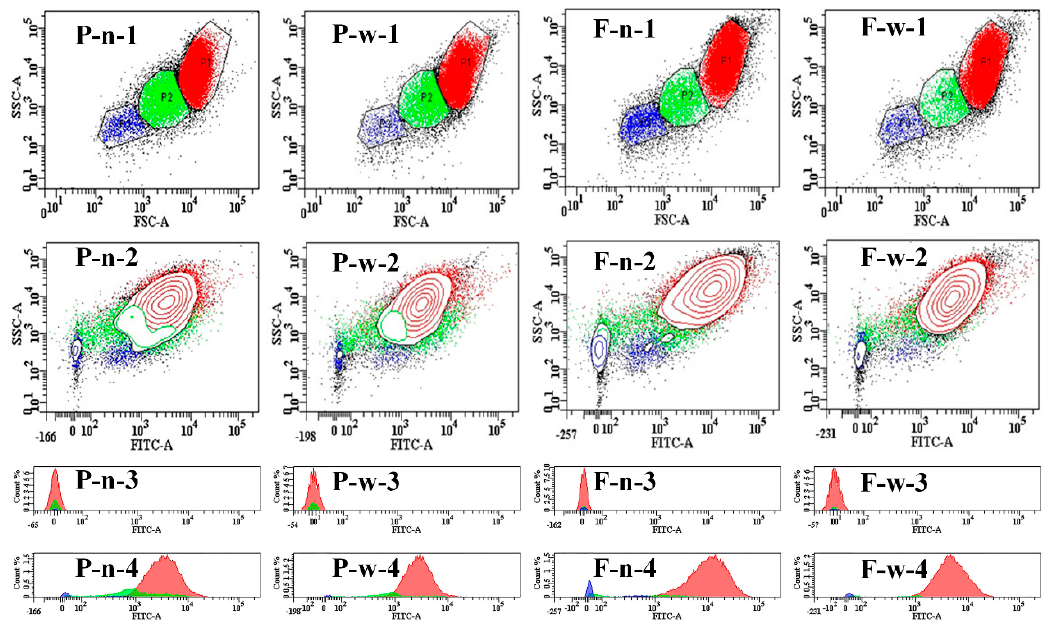
Figure 2. (P-n), non-waxy proso millet; (P-w), waxy proso millet; (F-n), non-waxy foxtail millet; (F-w), waxy foxtail millet. (1), forward-scattered light (FSC)-side-scattered light (SSC) image; (2), fluorescence image; (3), histogram of unstained starch (negative control); (4), histogram of 1-aminopyrene-3,6,8-trisulfonic acid (APTS)-stained starch. Table 2. Granule distribution of starches.